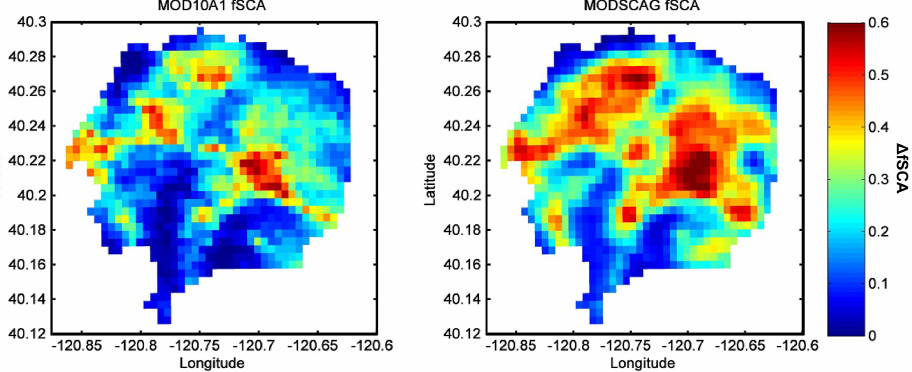
Figure 2. Pre- and post-fire MOD10A1 fSCA (left) and non-canopy-adjusted MODSCAG fSCA (right) difference maps for winter (January– March) over the region of the Moonlight Fire. Each image contains 1099 pixels.